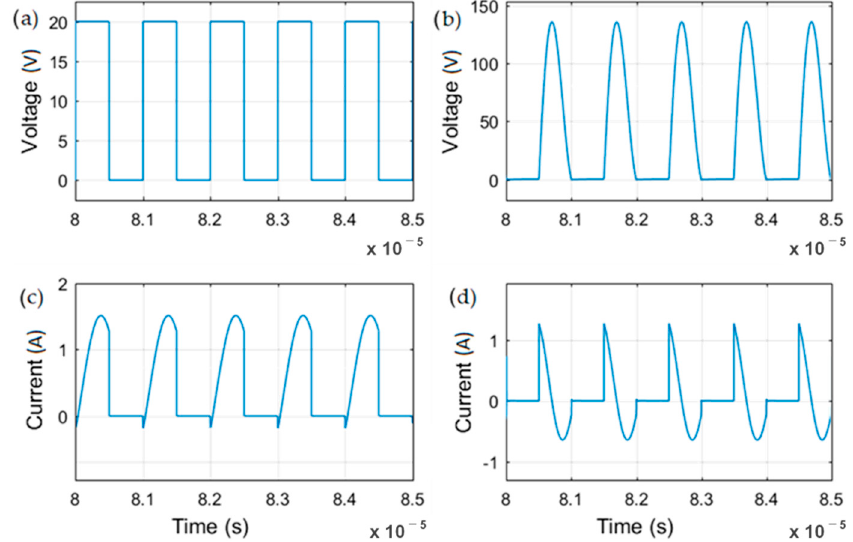
Figure 11. Waveforms of: ( a ) the pulse width modulation (PWM) signal controlling the gate of the transistor T 1 ; ( b ) the voltage drop U T on transistor T 1 ; ( c ) the current I t flowing through the transistor T 1 ; ( d ) the current I CT flowing through the output capacitor C T .